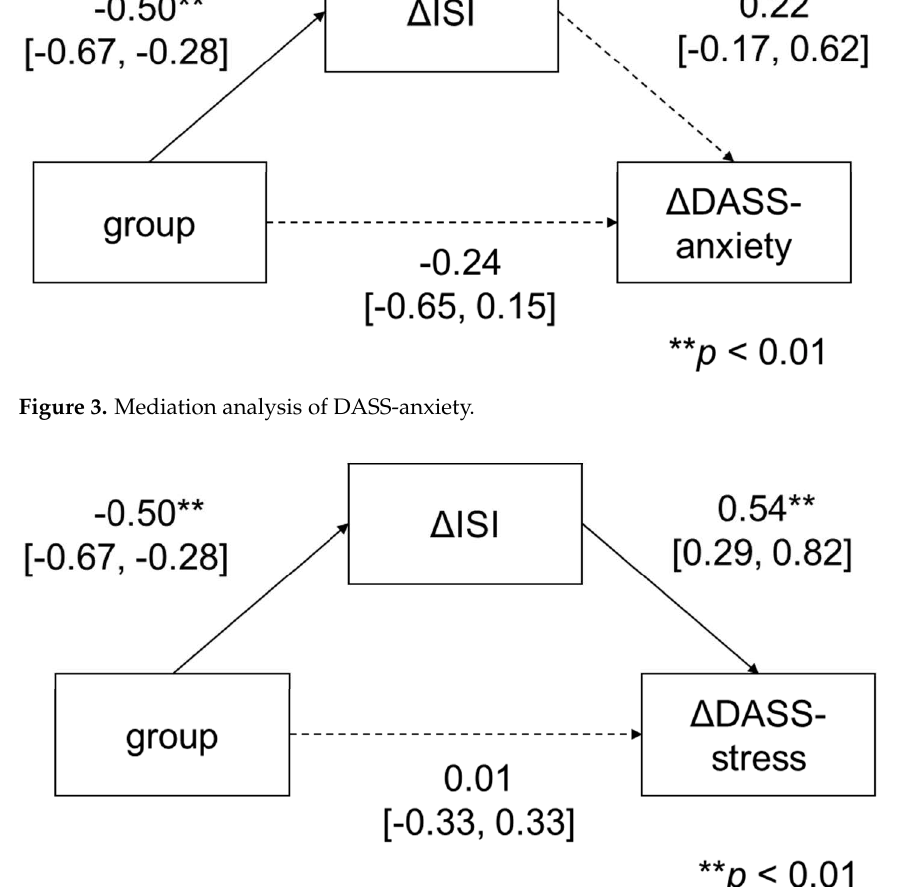
Figure 4. Mediation analysis of DASS-stress.